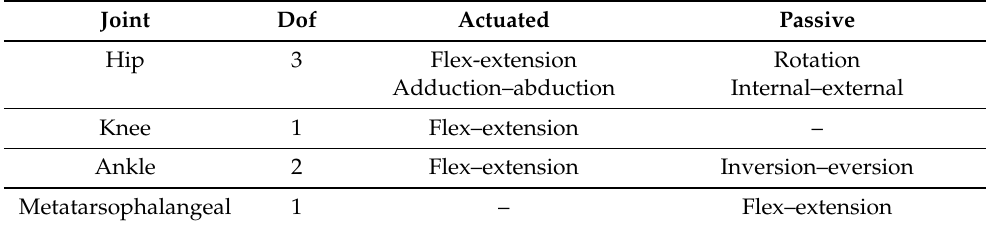
Table 1. Number of dofs on each leg.